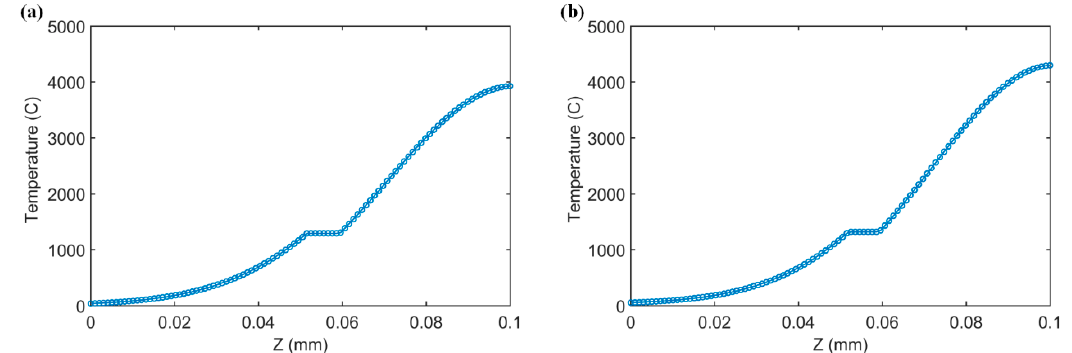
Figure 7. Stabilized temperature distribution from prediction along depths (z-direction) at laser scan locations ( x = 4 mm, y = 0.1 mm) for ( a ) single-track scan and ( b ) bidirectional scan under test 6 conditions. The minimum temperatures are at room temperature (20 °C). The determined absorption of 40% was used in the predictions.